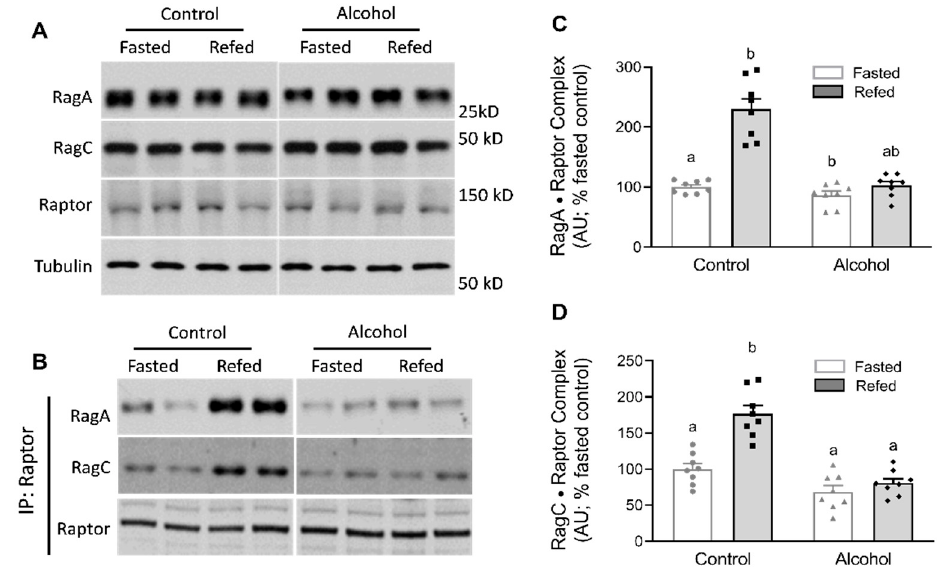
Figure 4. Alterations in Raptor, RagA and RagC after refeeding in the muscles of control and alcohol-receiving mice. ( A ), representative immunoblots for each. For RagA, RagC and Raptor, there were no significant treatment effects ( p > 0.05), and mean data are not shown. Although samples from all groups were loaded on the same gel, a gel break depicts lane(s) of the gel that have been deleted. In ( B ), Raptor was immunoprecipitated (IP) and Western blotting was performed on RagA ( C ), RagC ( D ) bound to Raptor. Bar graphs represent analyses for all immunoblots, where the mean of the fasted saline-treated control group was arbitrarily set at 100 AU. Values are mean ± SEM with n = 8/group. Only values having different superscript letters are statistically ( p < 0.05) different.